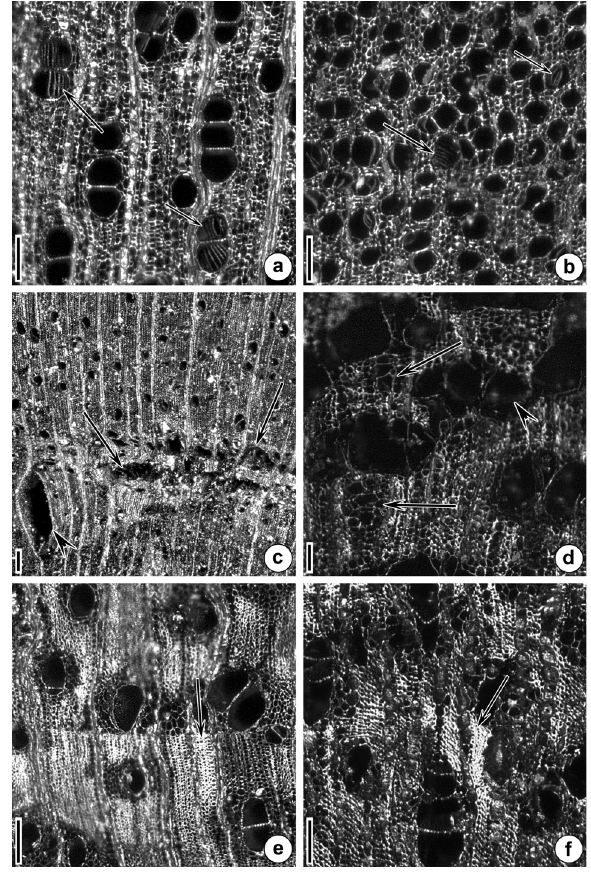
Figure 2 - Transverse section: a – Styrax ferrugineus , b – Symplocos pubescens , arrow points to multiple perforation plate in vessels. c – Vochysia tucanorum , arrows indicate traumatic canals. d – Guapira noxia , large arrowhead point to included phloem, thin arrows indicate vessels. e – Anadenanthera peregrina var. falcata , f – Terminalia glabrescens , arrows point to vitri fi cation. Bars: 100 μ m – a , b , d , e , f ; 200 μ m – c